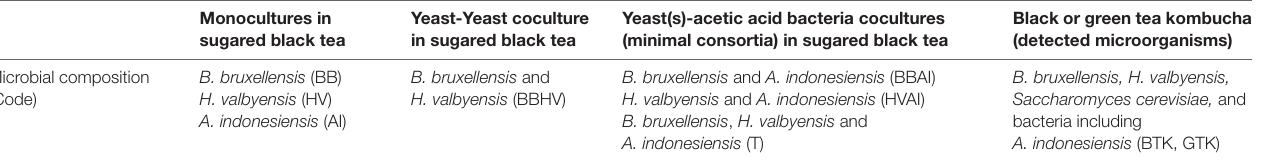
Black or green tea kombucha (detected microorganisms)